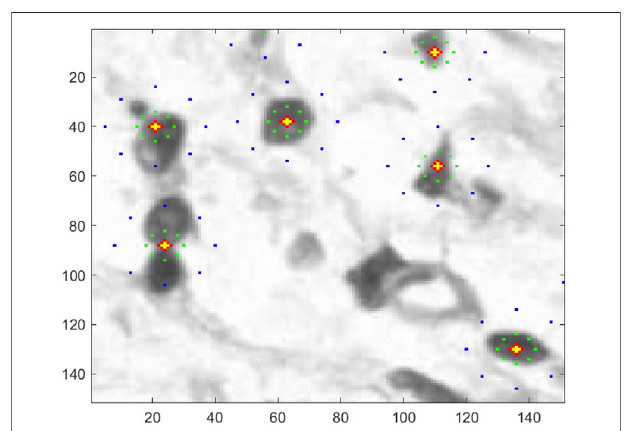
FIGURE 7 | Detail of a slide with examples of seed based instances.